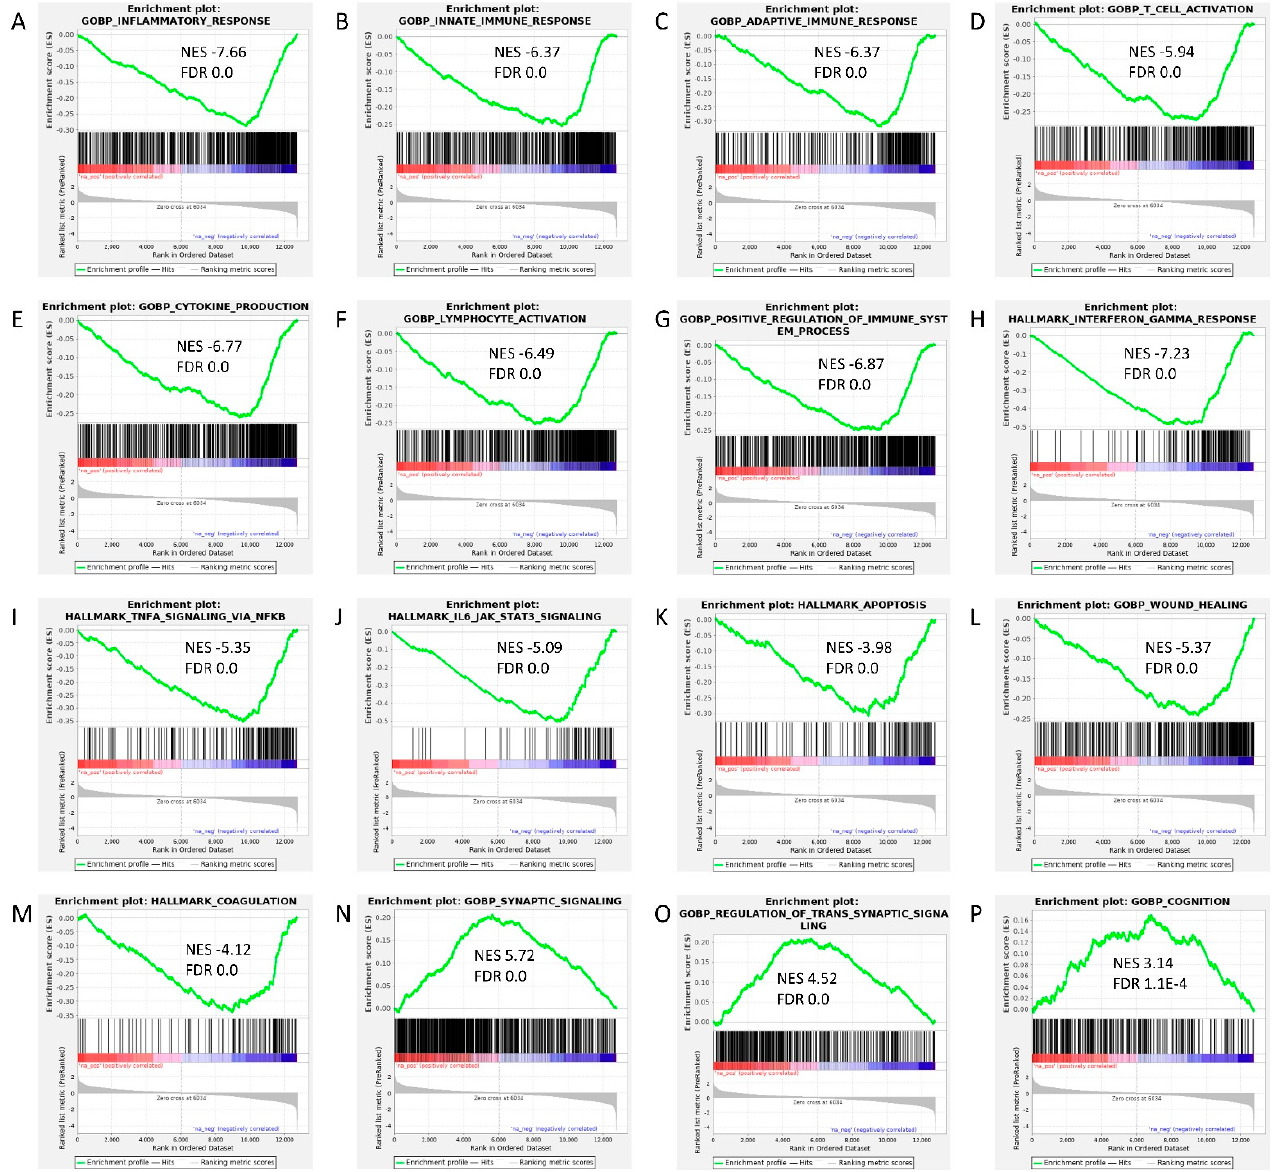
Figure 4. Gene Set Enrichment Analysis (GSEA) in mesenchymal stem cell-derived extracellular vesicle (MSC-EV)-treated SBH/y-DS rats. GSEA of differential expression between MSC-EV treated ( n = 4) and untreated ( n = 4) SBH/y-DS rats demonstrates that the following gene sets were downregulated in the treated rats: inflammatory response ( A ), innate ( B ) and adaptive ( C ) immune response, T cell activation ( D ), cytokine production ( E ), lymphocyte activation ( F ), positive regulation of immune system process ( G ), interferon gamma response ( H ), TNF signaling via NF κ B ( I ), IL6-JAK-STAT3 signaling ( J ), apoptosis ( K ), wound healing ( L ), and coagulation ( M ). Furthermore, the following gene sets were upregulated in the treated rats: synaptic signaling ( N ), regulation of trans-synaptic signaling ( O ), and cognition ( P ). Green curves show the accumulating enrichment. Normalized enrichment score (NES) and false discovery ratio (FDR) are shown for each gene set analyzed.